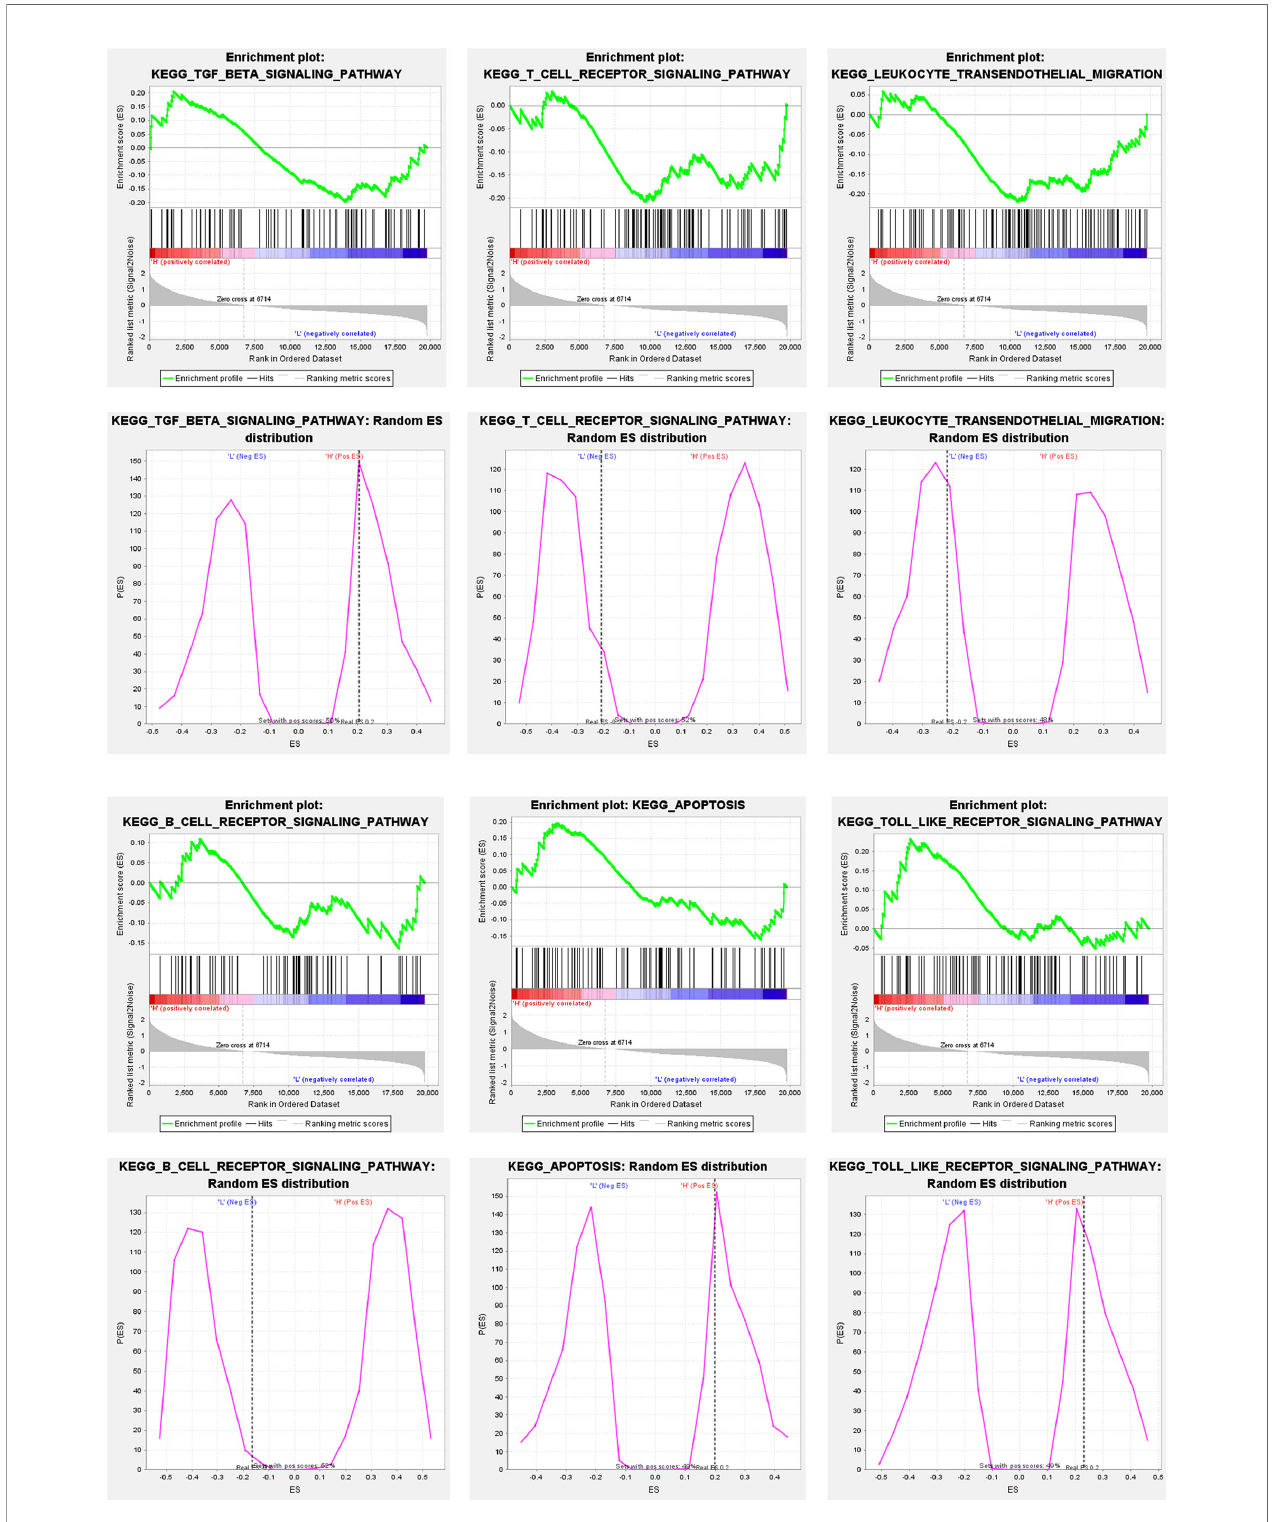
FIGURE 6 | GSEA for CCA cases in GSE26566 based on the level of APOB expression. It was observed that the TGF- b signaling pathway, T cell receptor signaling pathway, leukocyte transendothelial migration, B cell receptor signaling pathway, apoptosis pathway, and Toll like receptor signaling pathway were signi fi cantly